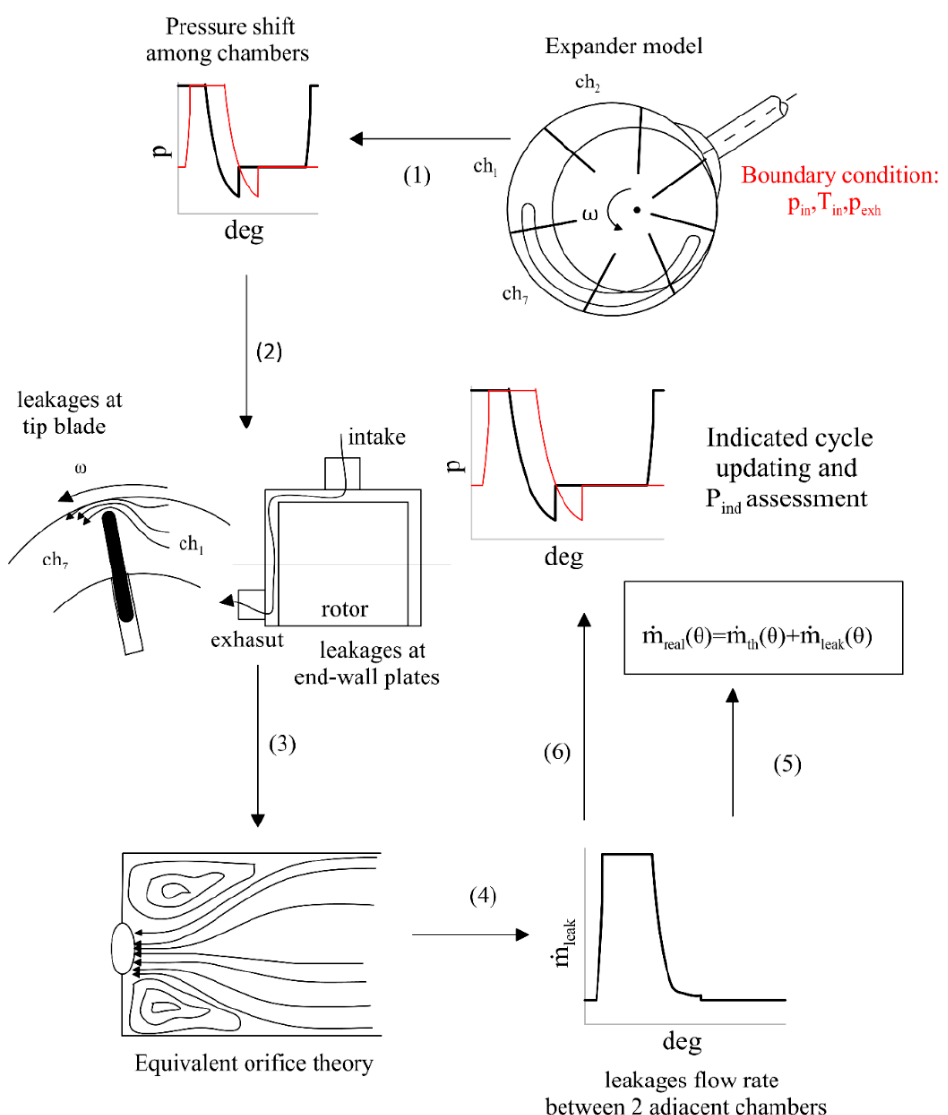
Figure 1. The theoretical model of the expander filling. Step (1): Definition of pressure inside the chamber without leakages; Step (2): Evaluation of leakages at tip blade and at the end-wall plate with equivalent orifice theory (Step (3)); Step (4): Calculation of leakages as a function of rotation angle; Step (5): Evaluation of real mass inside chambers; Step (6): Updating of the indicated cycle considering leakages.